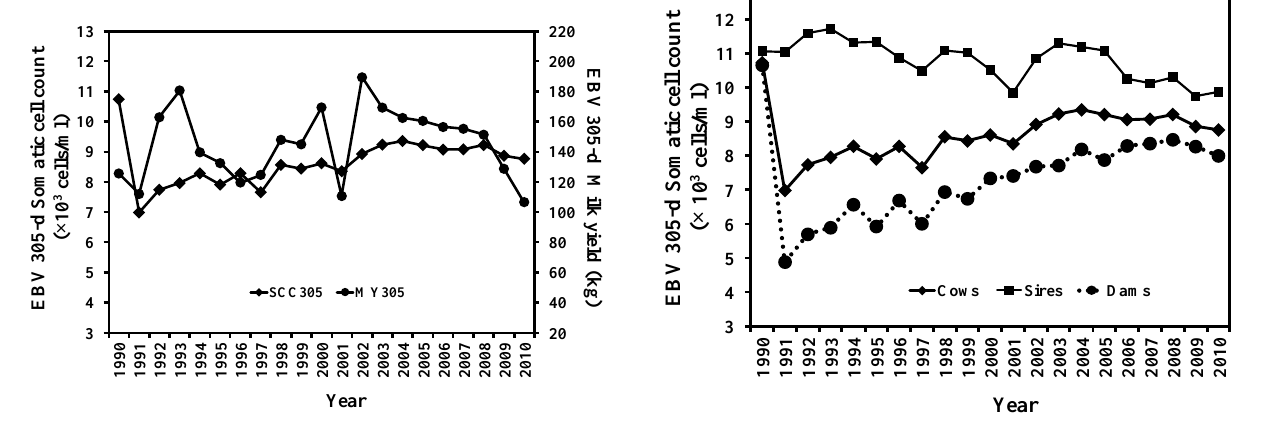
Figure 2. Yearly means of EBV for 305-d somatic cell count of cows, their sires and their dams from 1990 to